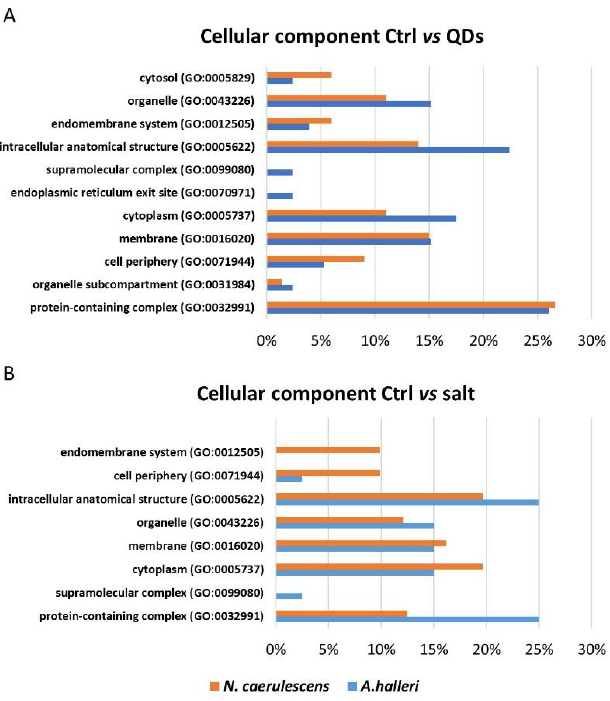
Figure 6. The GO analysis of cellular components. The genes list inserted are genes that code for proteins identified using comparative pairwise proteomic analysis between control, treated with metal QDs and metal salt. Blue bars represent the percentage of the proteins found in A. halleri , while orange bars represent the percentage of the proteins found in N. caerulescens